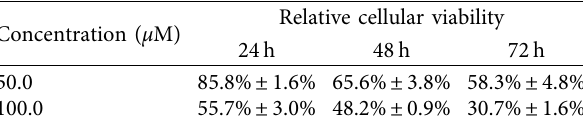
Table 2: Relative cellular viability of DBPP toward U2OS at 24, 48, and 72 h. Concentration ( μ